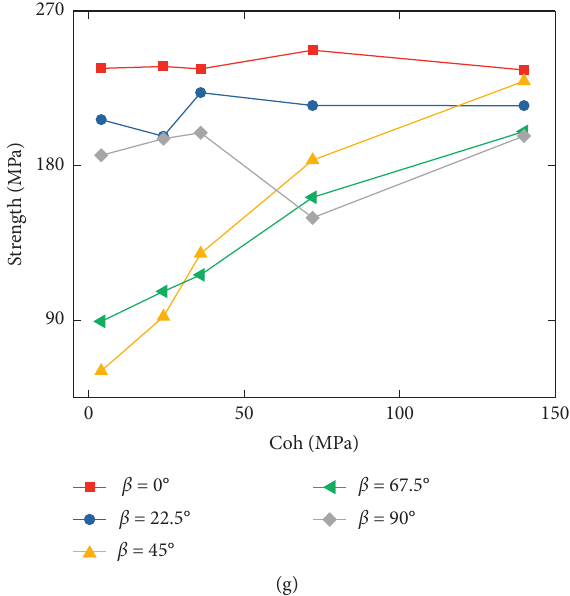
Figure 9: The cumulative distribution curve and average fragment size of layered rocks with different bedding shear strength. (a–e) The distribution curve of 0 ° , 22.5 ° , 45 ° , 67.5 ° , and 90 ° samples, red: coh � 4MPa, blue: coh � 24MPa, yellow: coh � 36MPa, green: coh � 72MPa, and gray: coh � 140MPa. (f) Average fragment size vs. bedding shear strength under different bedding angles. (g) Dynamic strength vs. bedding shear strength under different bedding